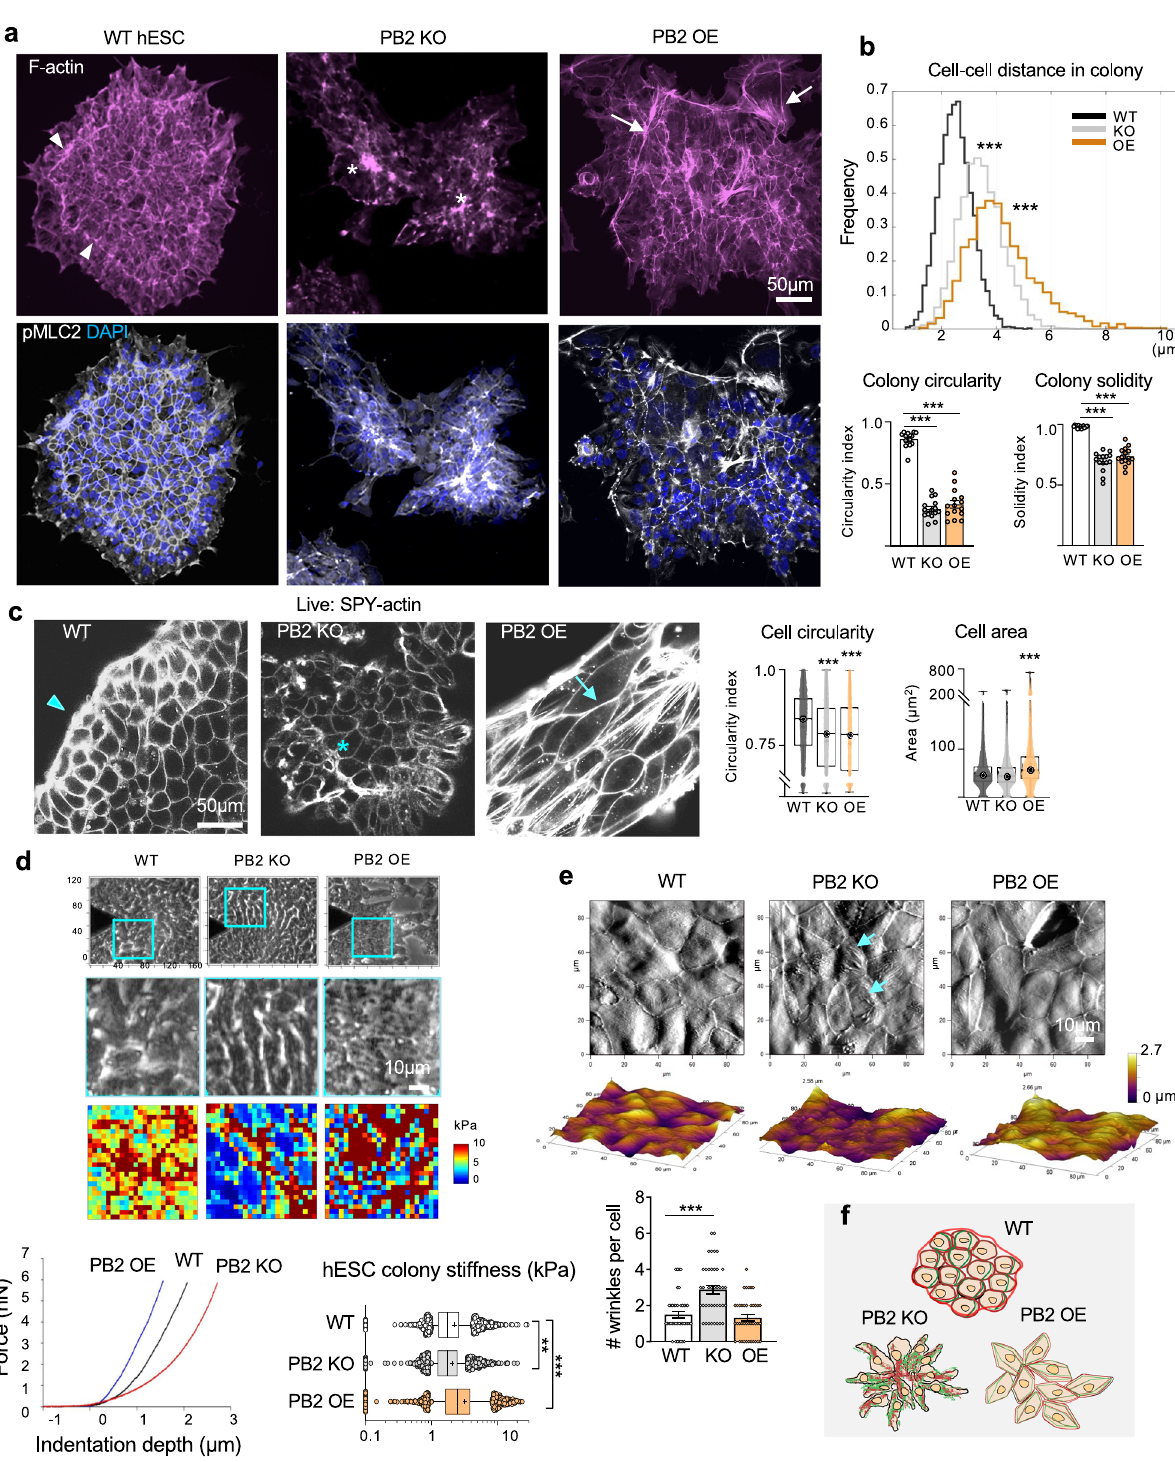
(Fig. 2e). Together, live-cell imaging and AFM measurements support the role of Plexin-B2 in orchestrating actomyosin organization and cytoskeletal tension during hESC colony formation (Fig. 2f).